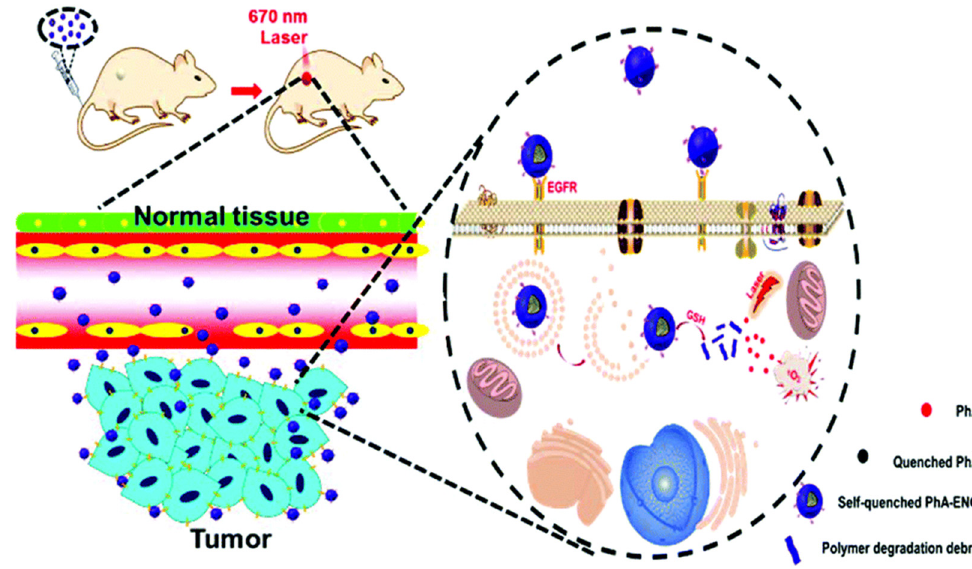
Figure 4. Schematic illustration of the smart self-quenched nanogel for targeted PDT. Reproduced from Ref. [166] with permission from the Royal Society of Chemistry.